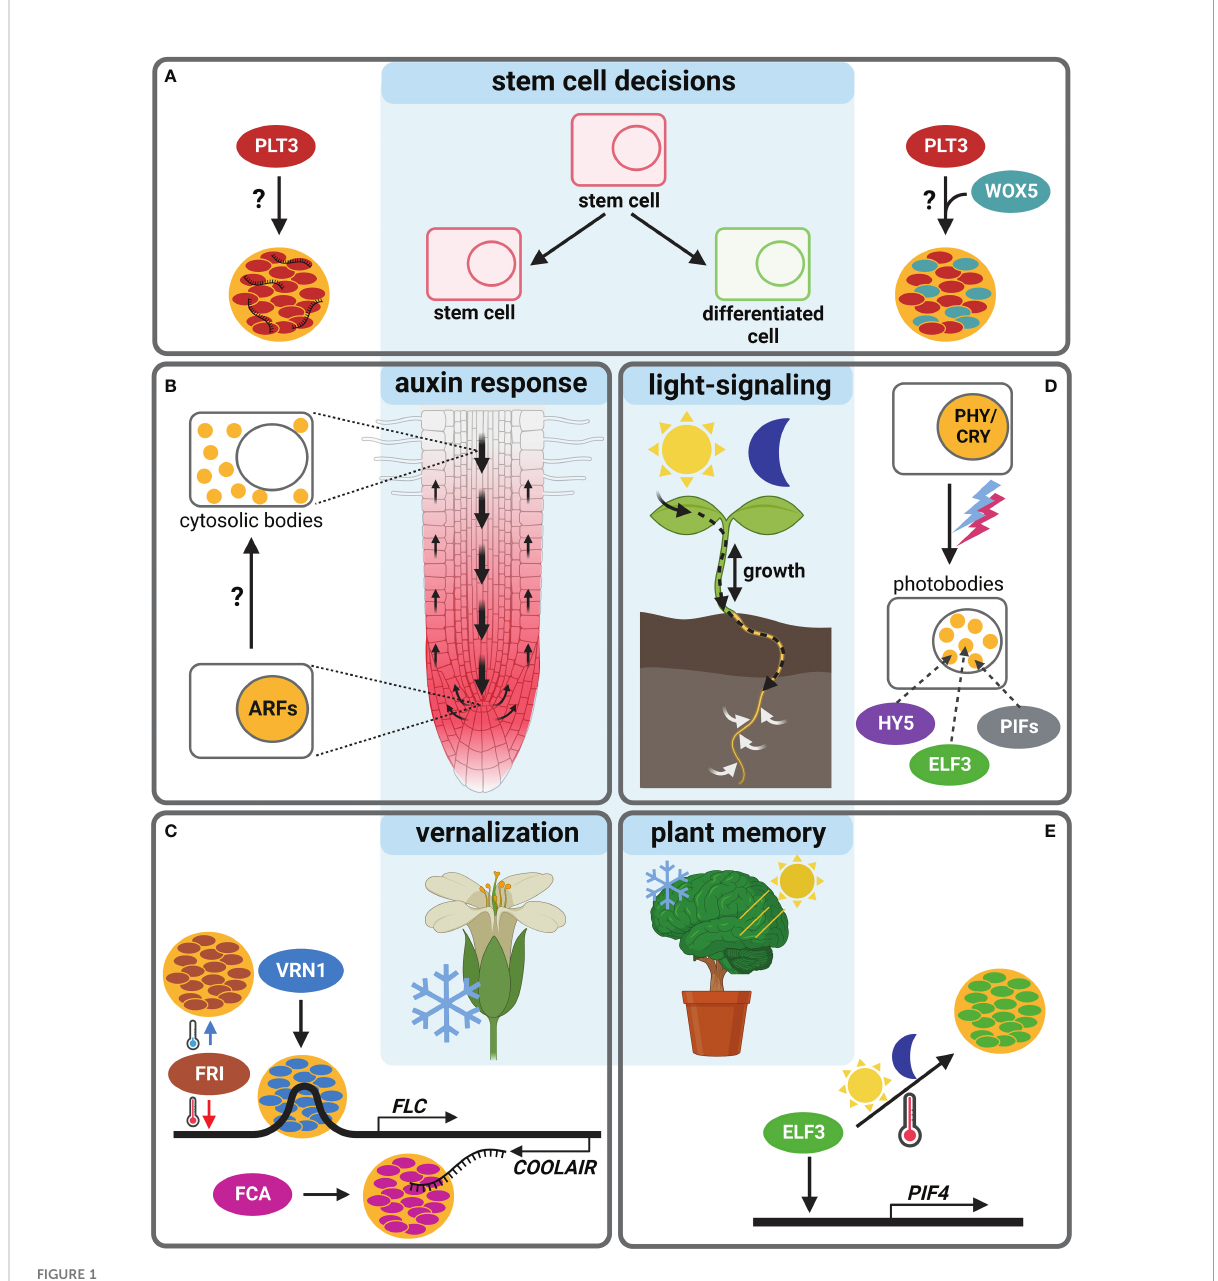
FIGURE 1 Body-formation of transcriptional regulators during Arabidopsis thaliana development. (A) The TF PLT3 (red) localizes to NBs (orange circles) in cells undergoing stem cell fate decisions, either with RNA (left) or together with WOX5 (cyan, right). (B) ARF TFs form cytosolic bodies (small orange circles) in certain cell types of the Arabidopsis root, initiating a cell type speci fi c auxin response. (C) The response to vernalization is regulated by NB formation (orange circles) containing FRI (brown), VRN1 (blue) or FCA (pink). (D) Photobodies (small orange circles) form in response to light and contain HY5 (purple), ELF3 (green) and PIFs (grey). (E) ELF3 forms NBs (orange circle) in response to warm temperatures and is also involved in circadian clock responses raising the question if this is needed for plant memory. Created with